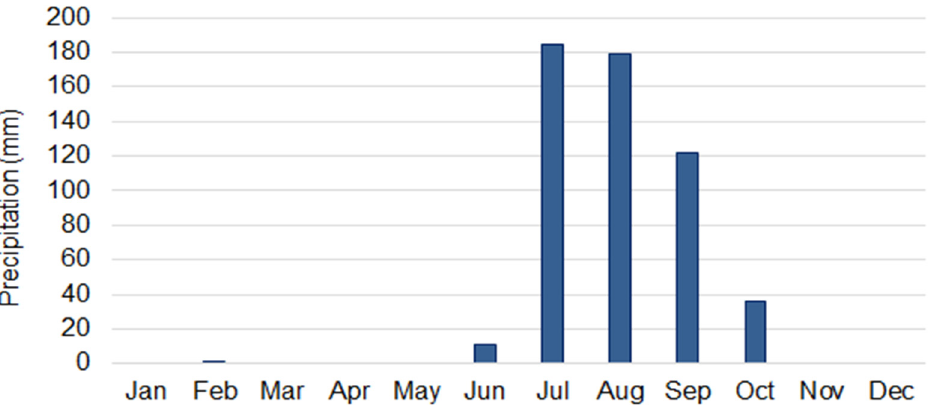
Figure 2. Monthly average precipitation in Niamey (data from [35]).